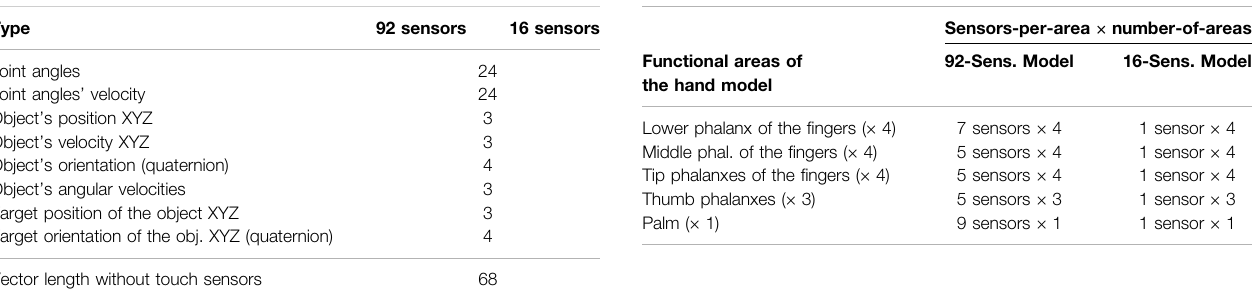
TABLE 1 | Neural Network Input Vector in the Hand Environments.